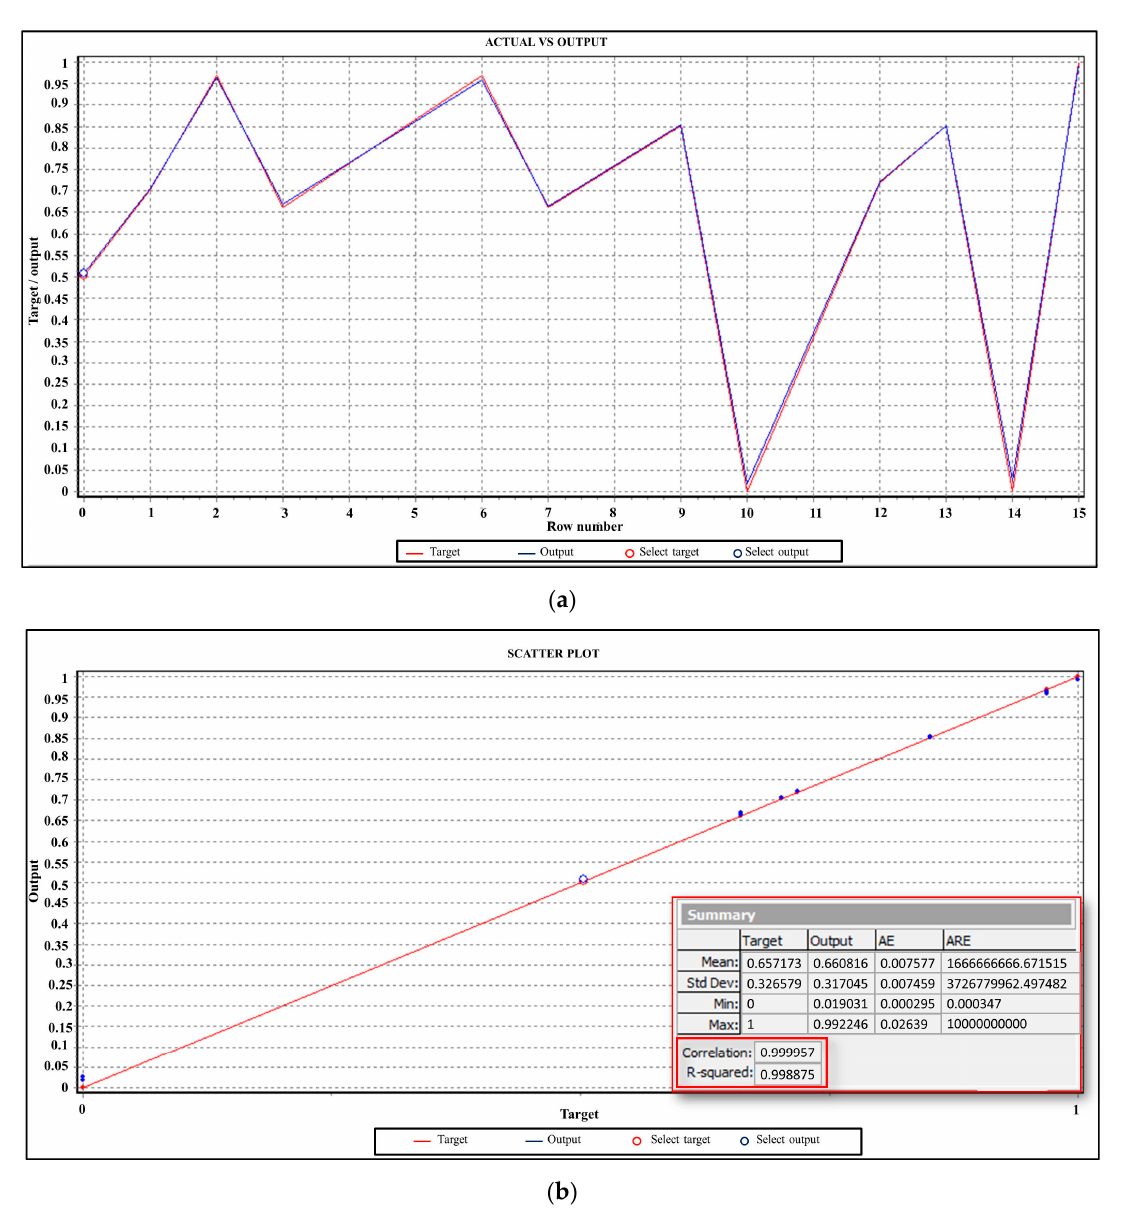
Figure 7. Simulation results: ( a ) Predicted Vickers HAZ micro hardness by ANN versus the experimental data; and ( b ) regression line at the training stage.